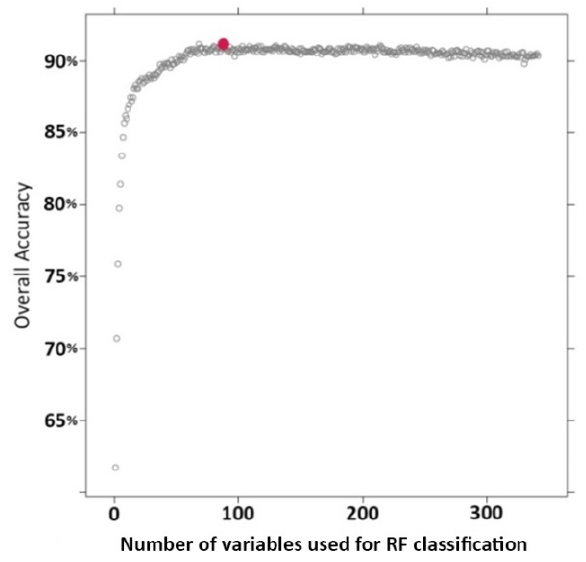
Figure 3. Evolution of cross-validated (5-fold) overall accuracy according to the number of variables used for classification at level 1 (cropland). The variables were previously ranked by order of importance based on the MDA measure.